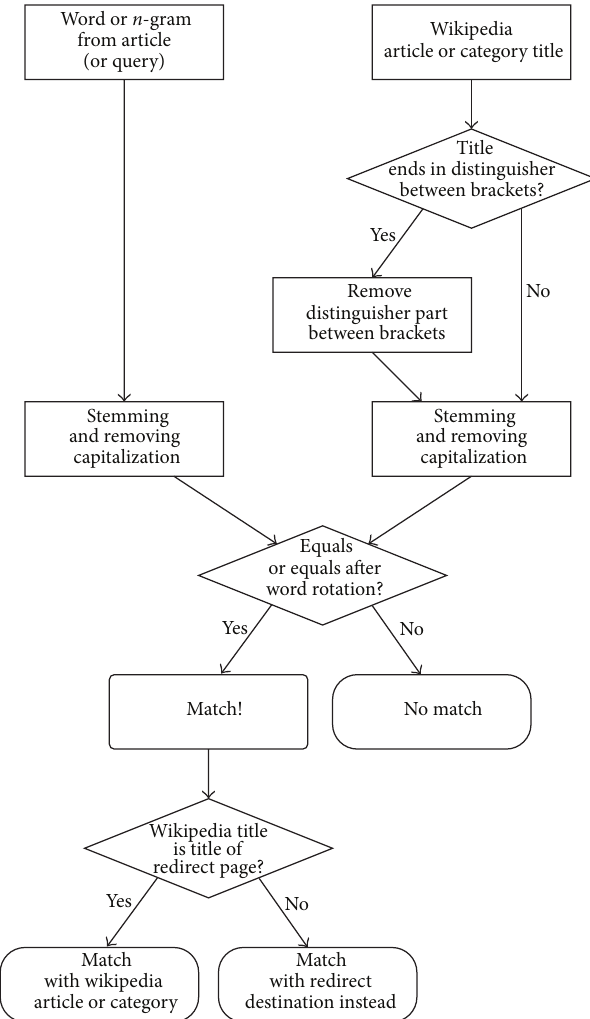
Figure 3: Flowchart of the matching algorithm.